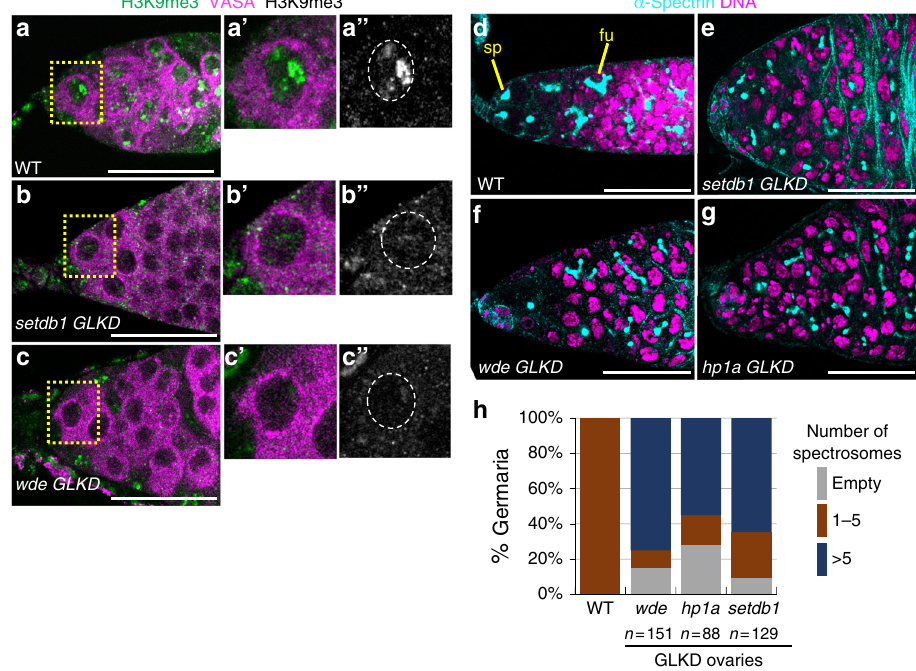
Fig. 1 H3K9me3 is required for germ cell differentiation. a – c Reduced H3K9me3 staining in germ cells upon SETDB1 and WDE depletion ( GLKD , see text for details ) . Representative confocal images of a wild-type (WT), setdb1 GLKD, and wde GLKD germarium stained for H3K9me3 (green, white in a ”– c ” ). Germ cells were identi fi ed by α -VASA staining (magenta). Scale bar, 25 μ m. Insets show a higher magni fi cation of a single germ cell, in which the nucleus is outlined by a white dashed line in a ”– c ” . d – g Undifferentiated germ cells accumulate in setdb1 GLKD, wde GLKD , and hp1a GLKD mutant germaria. Representative confocal images of wild-type and mutant germaria stained for DNA (magenta) and α -Spectrin (cyan) to visualize spectrosomes (sp), fusomes (fu), and somatic cell membranes. Scale bar, 25 μ m. h Quanti fi cation of mutant germaria with 0, 1 – 5, and >5 round spectrosome-containing germ cells. The number of scored germaria ( n ) is